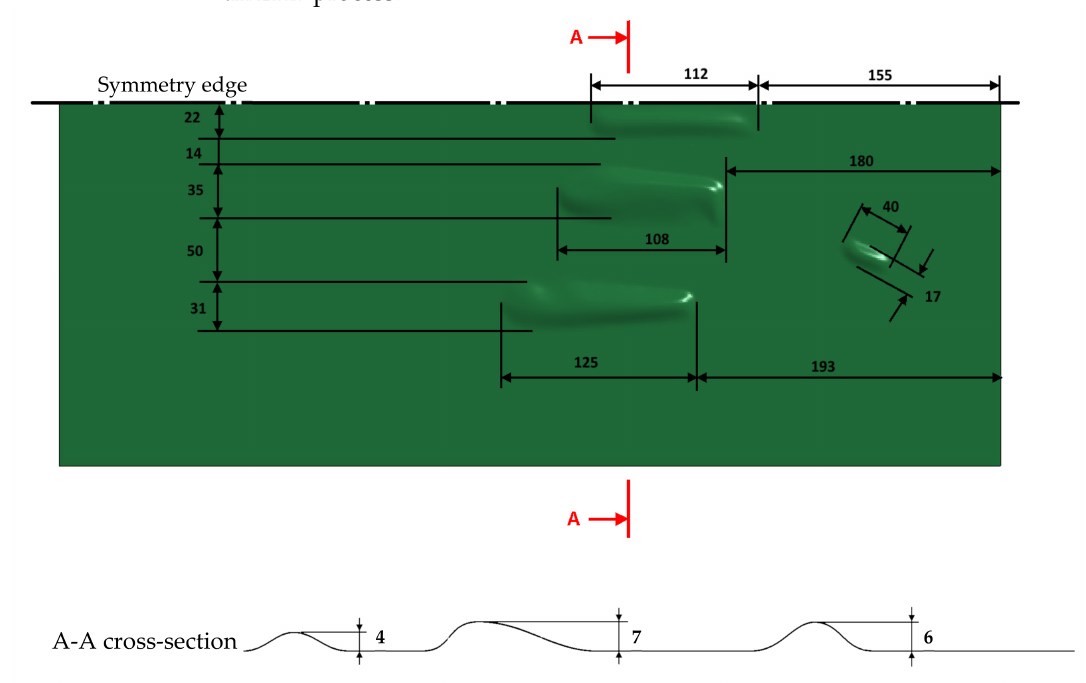
Figure 12. Preform